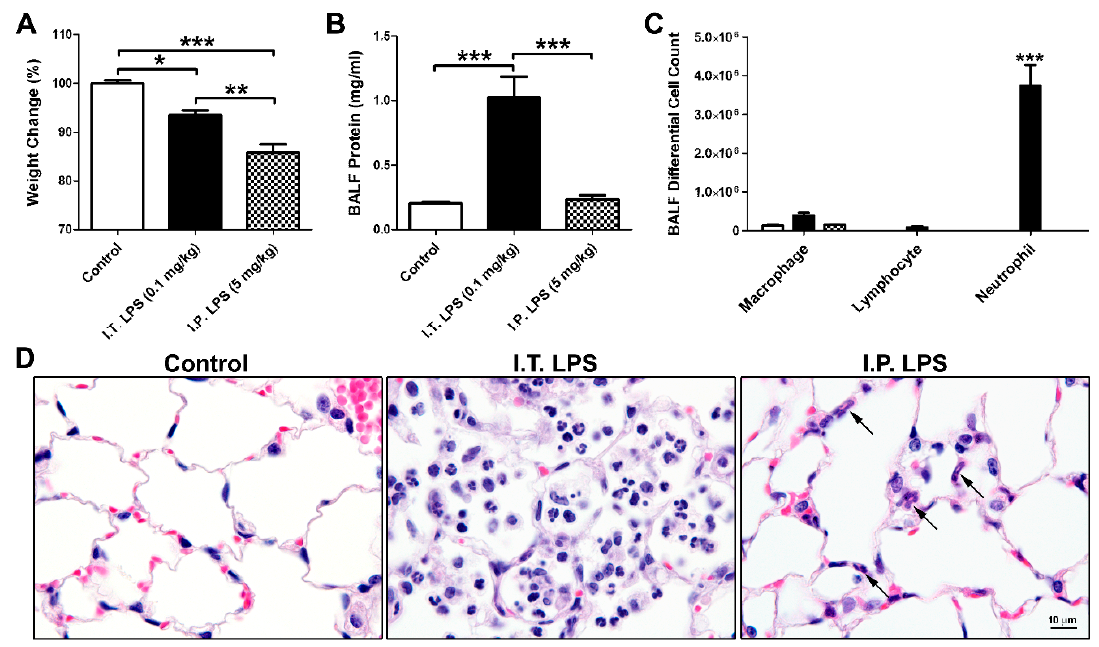
Figure 1. LPS-induced direct and indirect lung injury in mice. ( A ) Weight changes (% of beginning body weight) at 48 h following control, I.T. and I.P. LPS treatment in mice. N = 6 in each group; ( B ) BALF protein concentration; ( C ) BALF differential cell count. *, p < 0.05; **, p < 0.01; ***, p < 0.001; ( D ) H&E staining of lung sections from control, I.T. and I.P. LPS treated mice. Arrows,